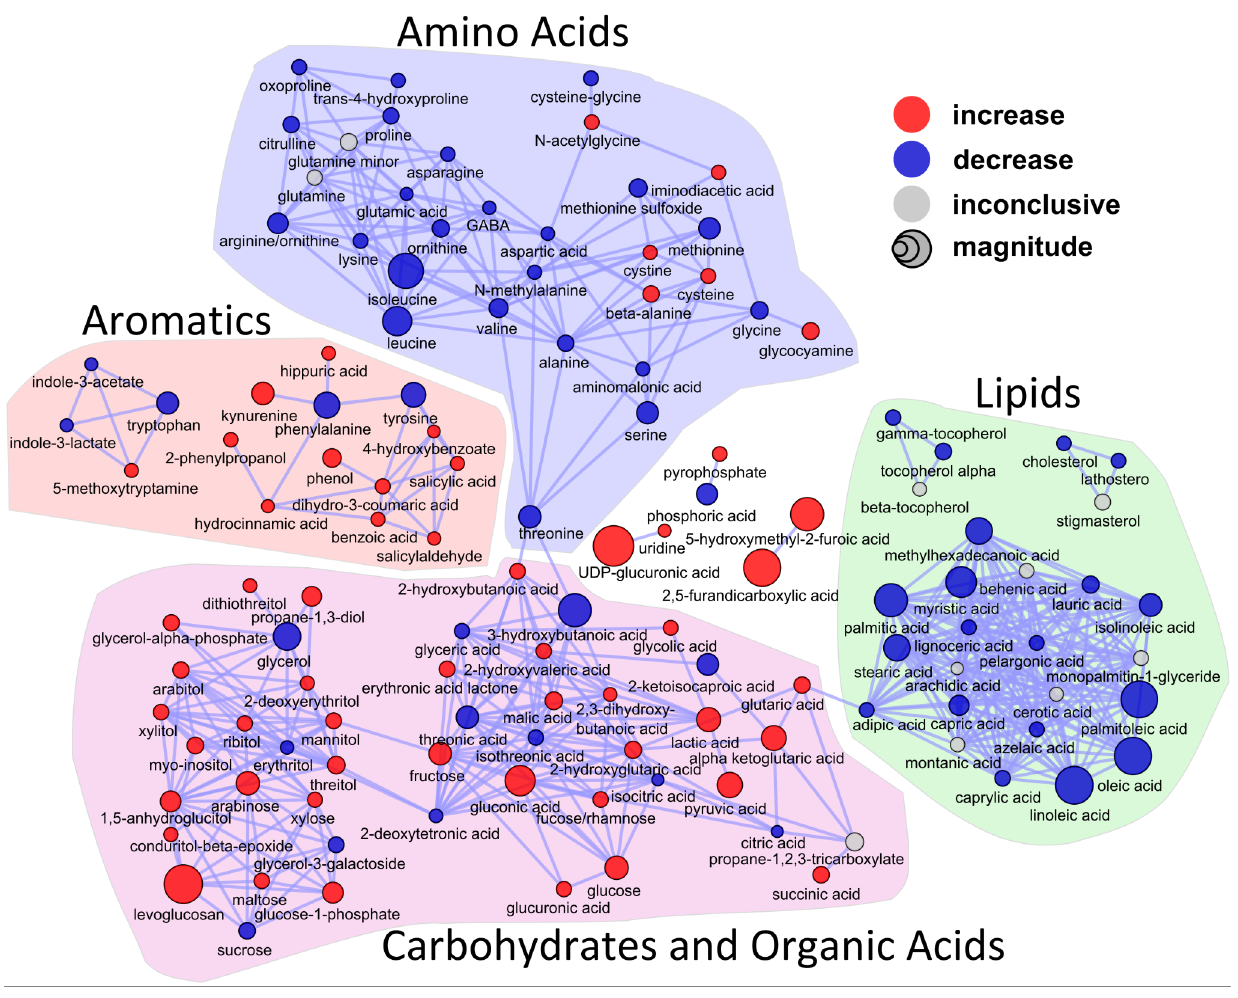
Figure 3. A chemical similarity network of identified metabolites was used to visualize OGTT-associated changes in metabolite levels following an OGTT in women. Vertices represent metabolites that are connected by edges (lines) based on chemical similarity (Tanimoto similarity . 0.7). Loadings on the first latent variable in the PLS model for metabolic changes correlated with time during the OGTT are mapped to vertex size (absolute loading) and color is used to display the direction of the change (sign of loading: red, increase; blue, decrease; gray, unclear change or differential change in pre- vs. post-intervention conditions).